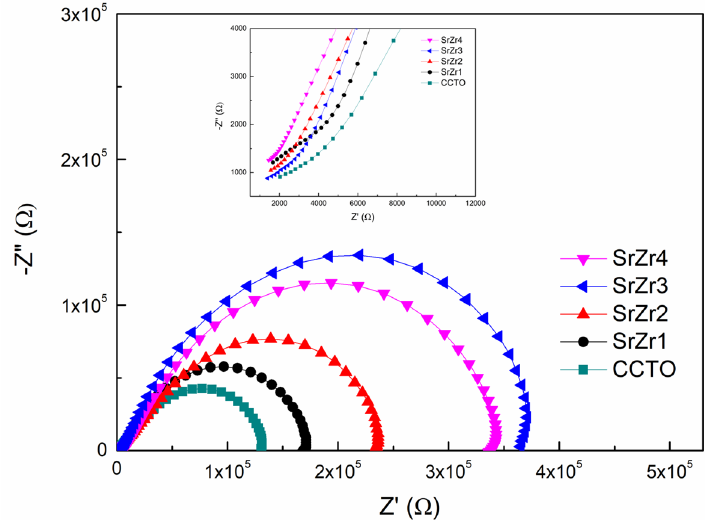
Figure 7. Impedance spectra of CCTO, SrZr1, SrZr2, SrZr3, and SrZr4 ceramics, where the inset presents an enlarged view near the origin.